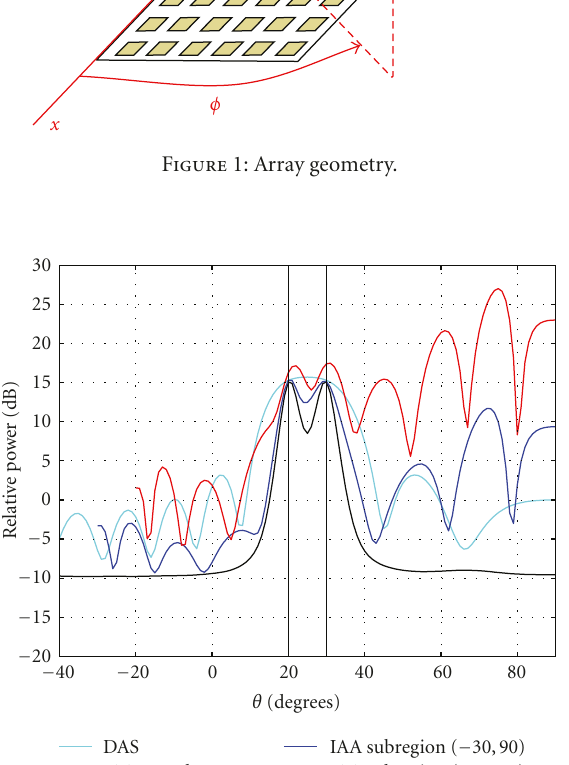
Figure 2: Performance degradation e ff ects of the IAA solution for di ff erent degrees of scanning region limitation (linear array, θ 1 = 20 ◦ , θ 2 = 30 ◦ , SNR 1 = SNR 2 = 15 dB, and f c = 1575MHz). signals impinging on the array. As an inconvenience,